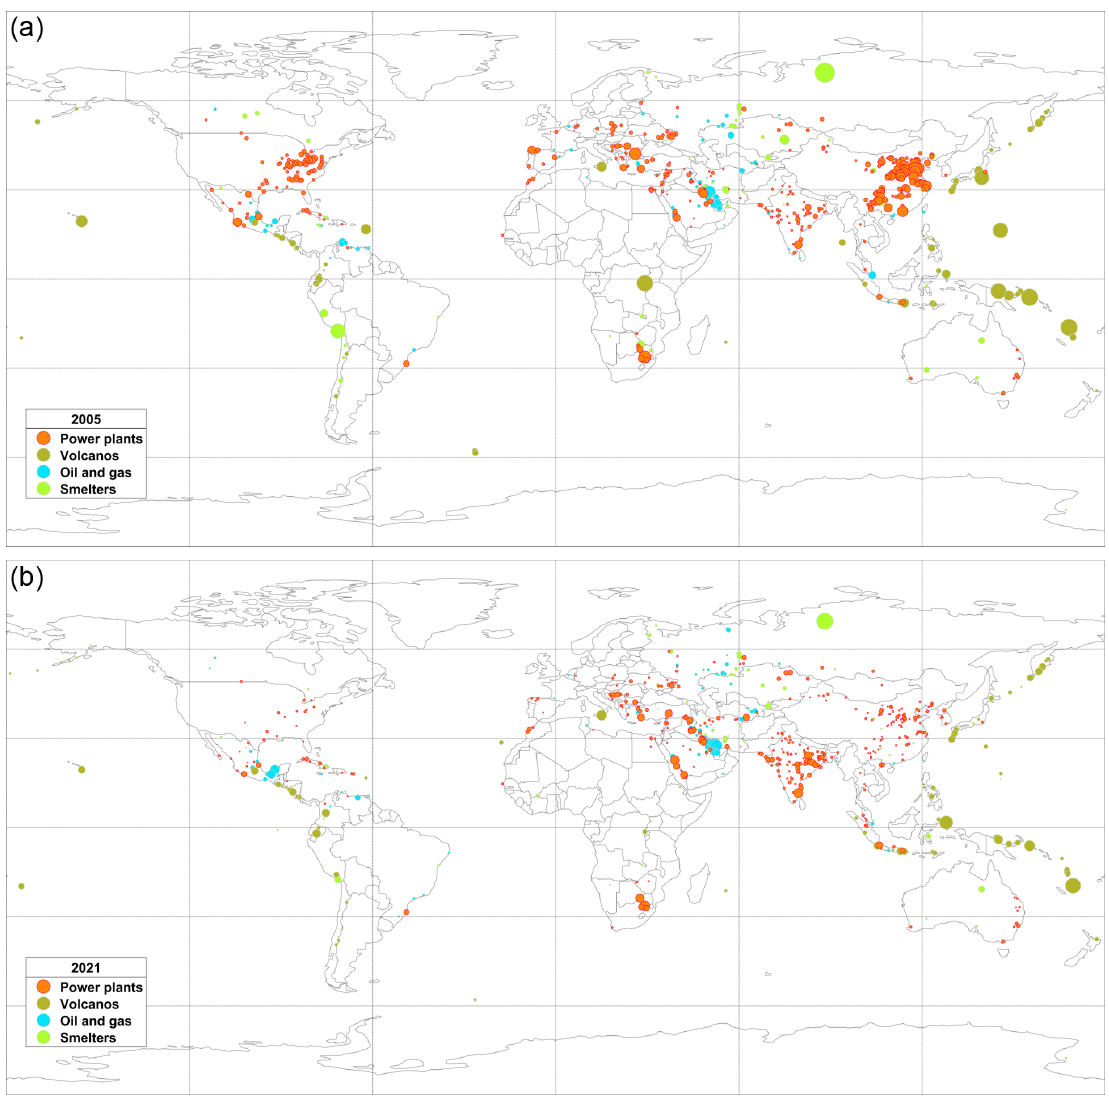
Figure 7. SO 2 emissions sources listed in the version 2 catalogue for 2005 (a) and 2021 (b) . Only sources where the ratio of the emission value to its standard deviation is greater than 3 are shown. The size of the symbols is proportional to the annual emission